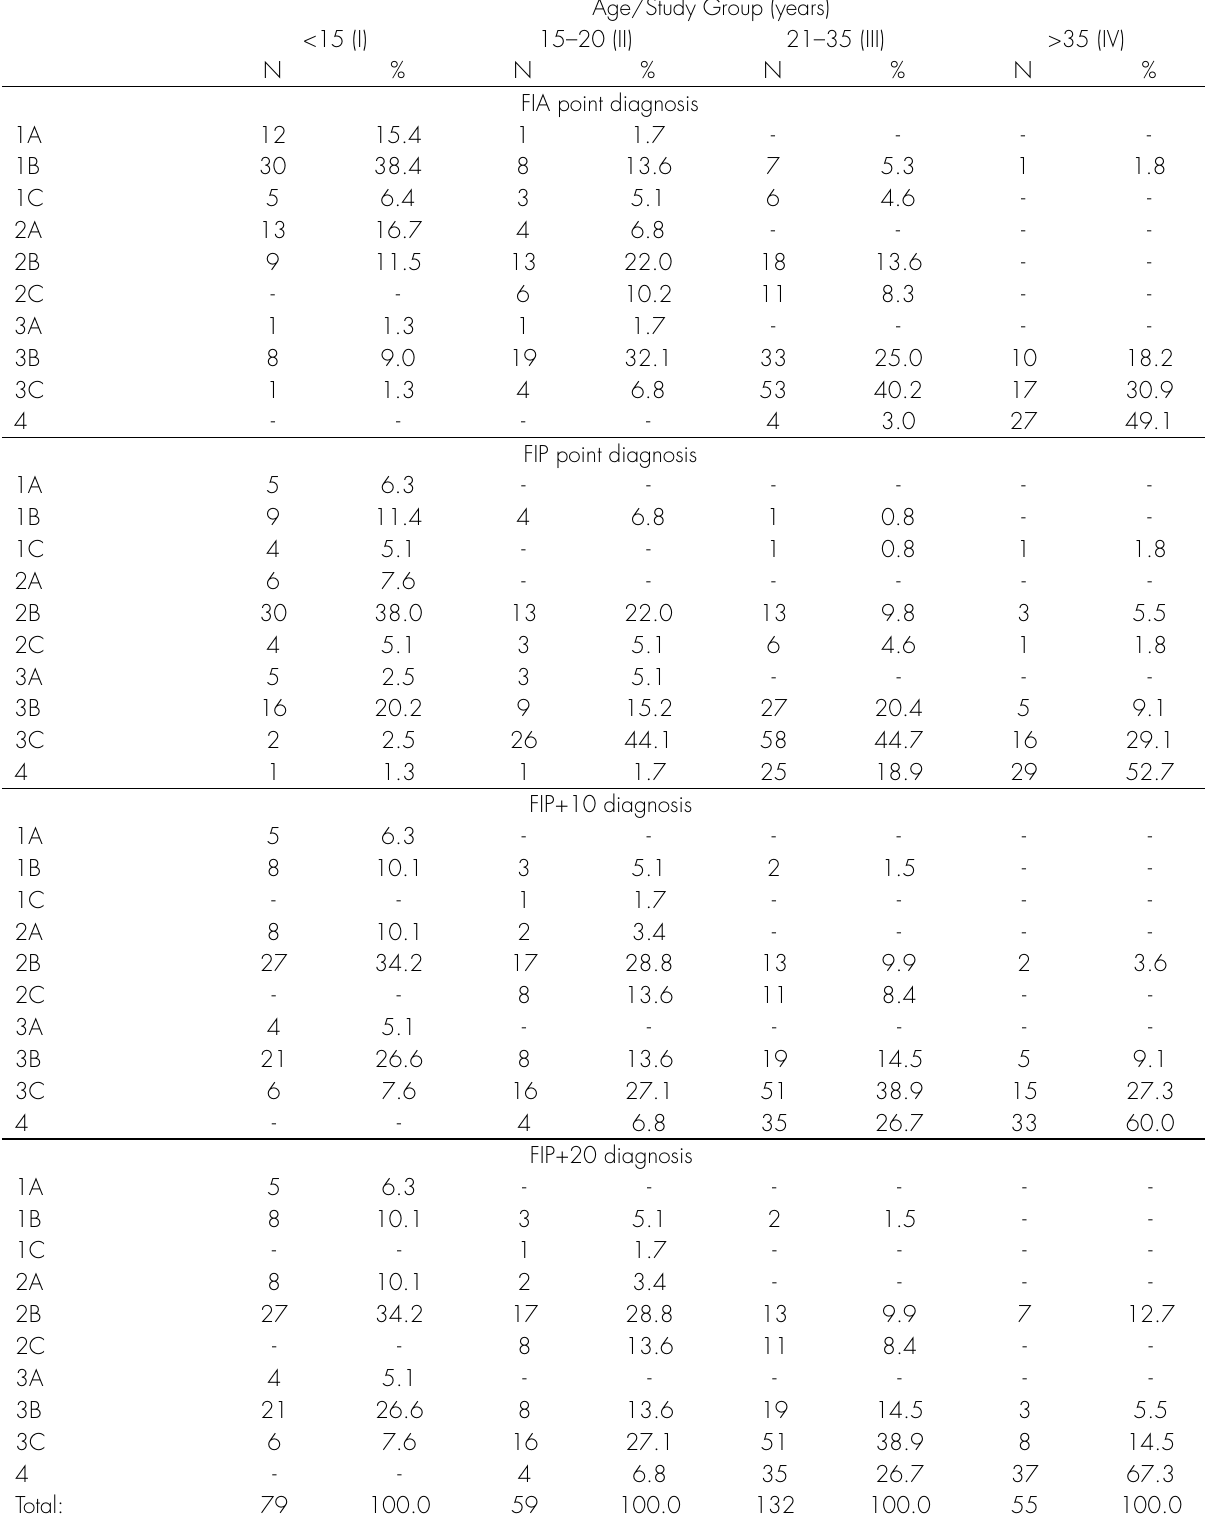
Table II. Relation between patients’ age and median palatal suture morphology in topographic points FIA (at the anterior margin of incisive foramen), FIP (at the posterior margin of incisive foramen), FIP+10 (10 mm distally from the posterior margin of incisive foramen) and FIP+20 (20 mm distally from the posterior margin of incisive